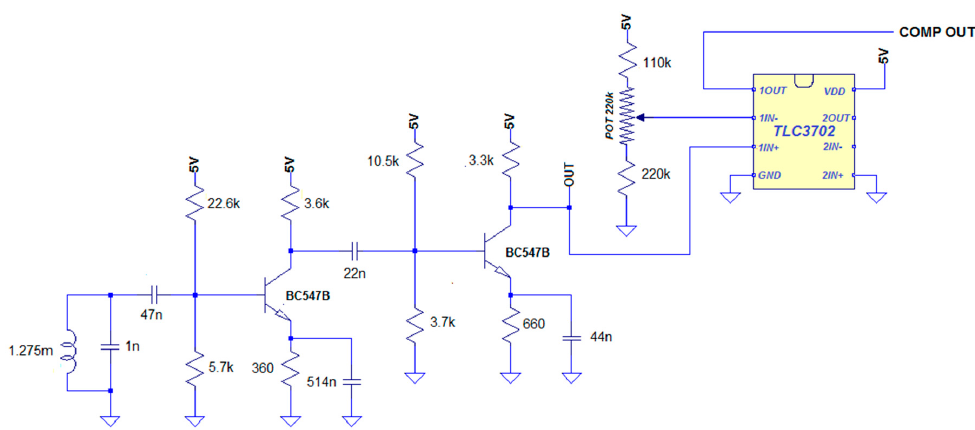
Figure 9. Complete analog front-end schematic: the amplifier circuit feeds the amplified signal to the TLC3702, which compares it with the reference voltage, adjusted by the user with a potentiometer.